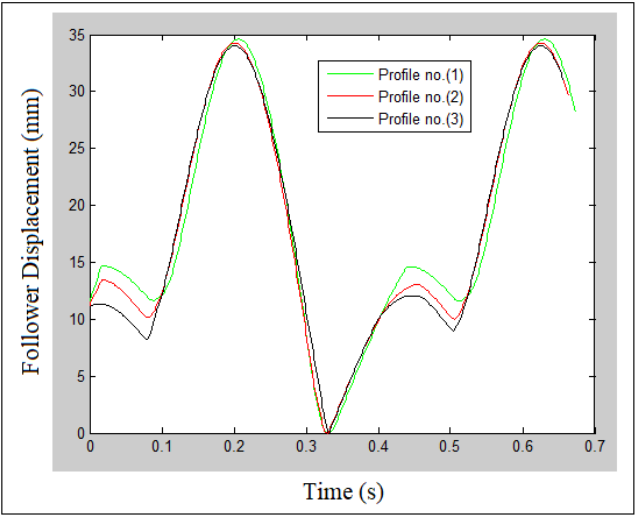
Figure 4. Nonlinear response against time for the three involutes’ profiles of the cam.